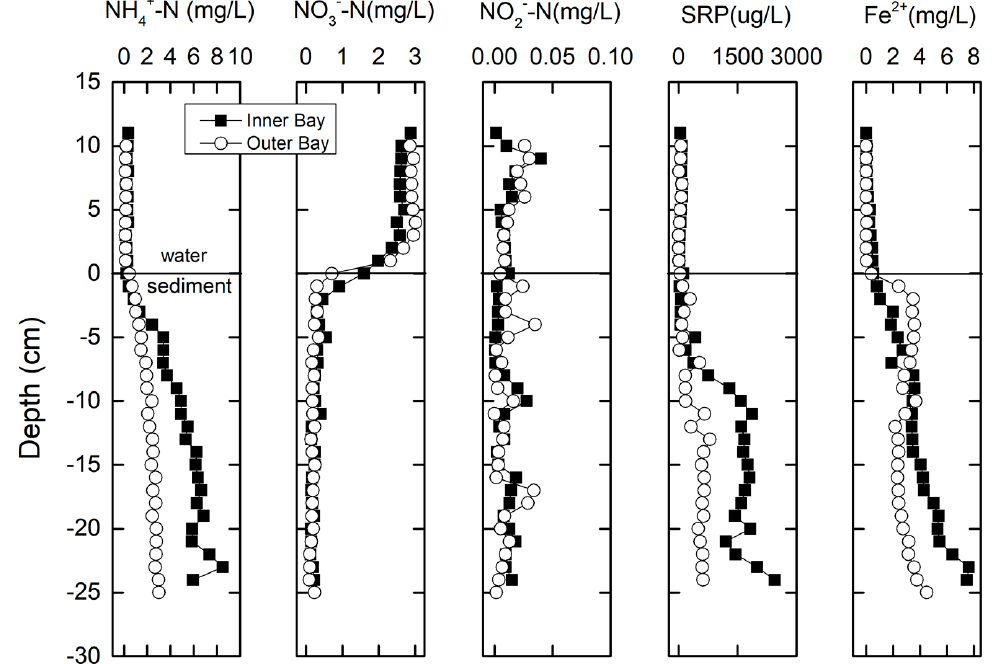
Figure 3. Depth profiles of selected chemical characteristics of porewater in Inner Bay and Outer Bay, samples were collected in January 2013.